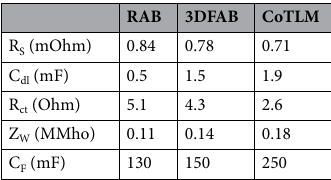
Table 3. Calculated values of RS, CPE, Rct, ZW, and CF through CNLS fitting of the experimental impedance spectra based upon the proposed equivalent circuit.